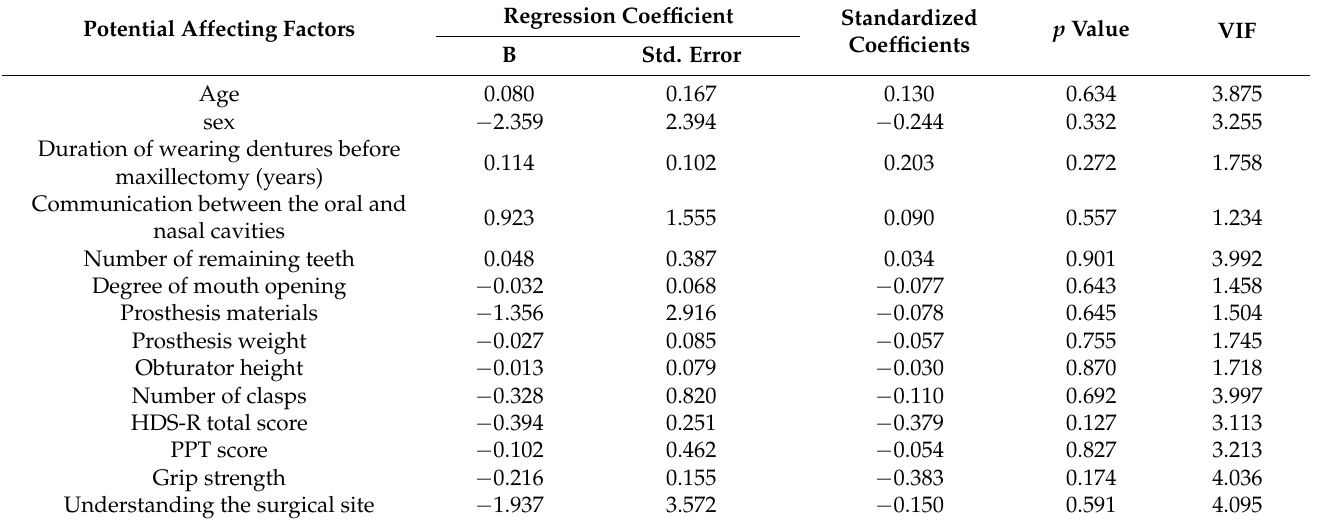
Table 6. Results of multiple regression analysis for all factors hypothesized to affect prosthesis insertion time in patients with maxillectomy.